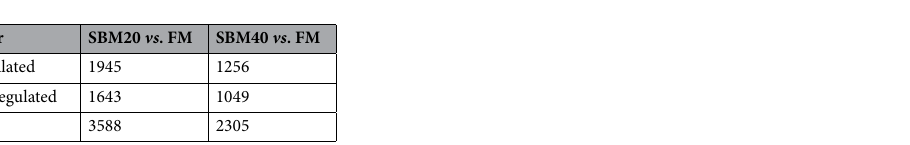
Table 7. Statistics of DEGs in DI tissues of pearl gentian grouper fed by different levels of SBM diets (n = 4).